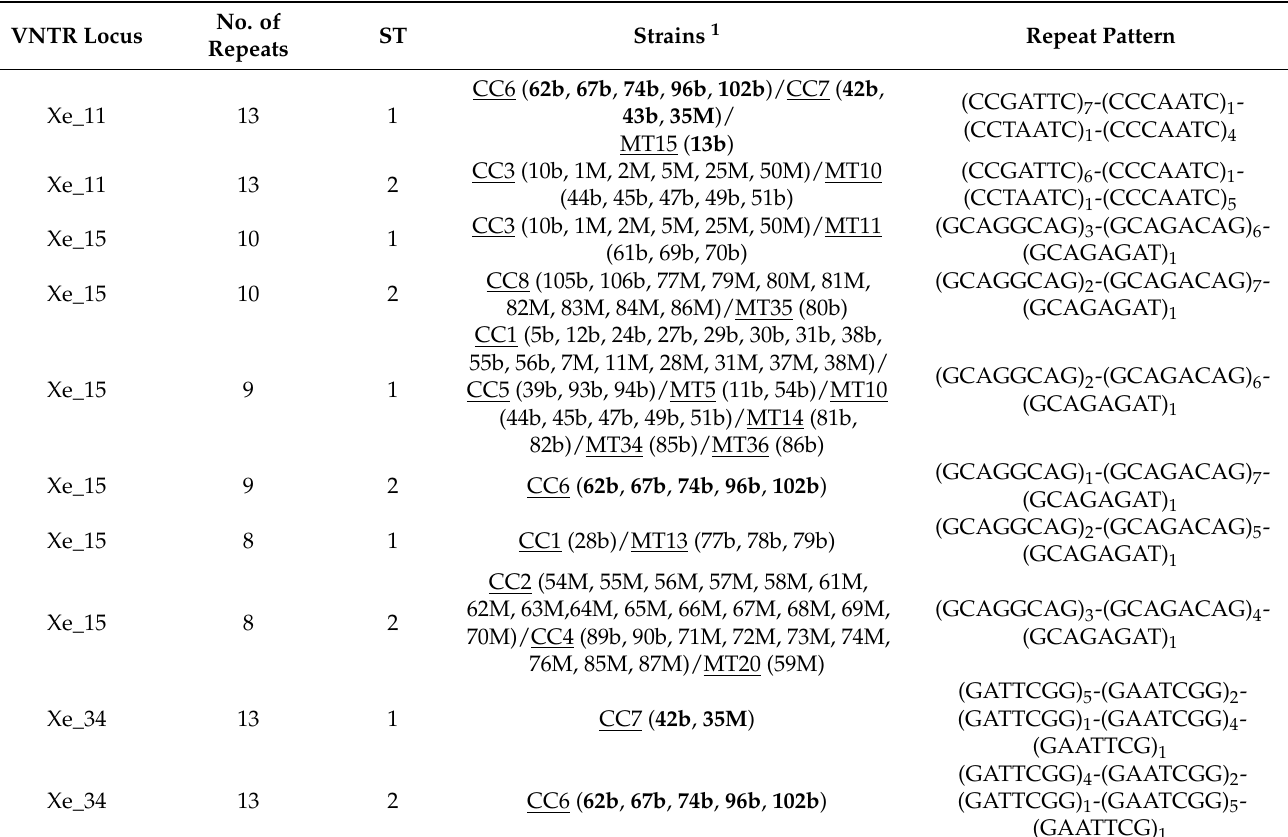
Table 2. VNTR loci with size homoplasy, as revealed by their sequence type (ST). No. of VNTR Locus